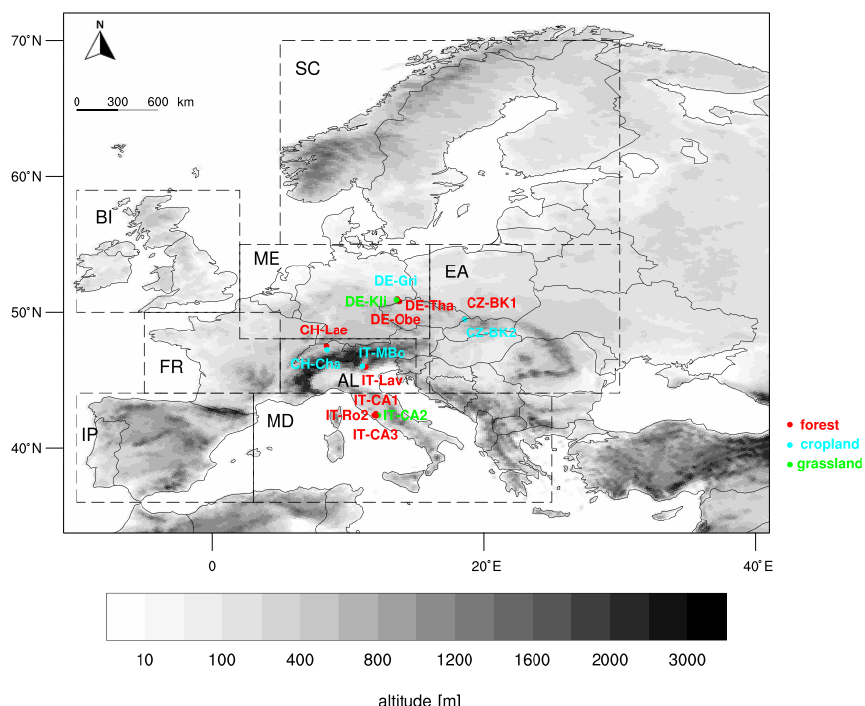
Figure 1. Topography of the model domain and location of the observational pairs. The outlined boxes with a dashed line correspond to the eight regions on which our analysis has been focused: AL (Alps), BI (British Isles), EA (Eastern Europe), FR (France), IP (Iberian Peninsula), MD (Mediterranean), ME (Mid-Europe), SC